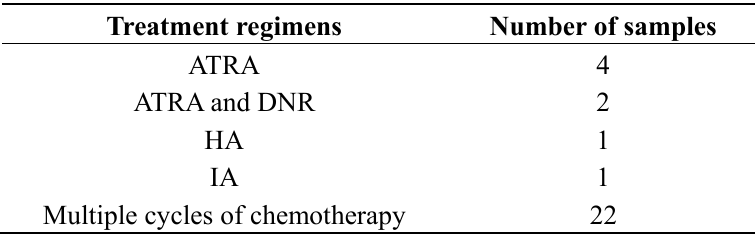
Table 2. Treatment regimens of AML